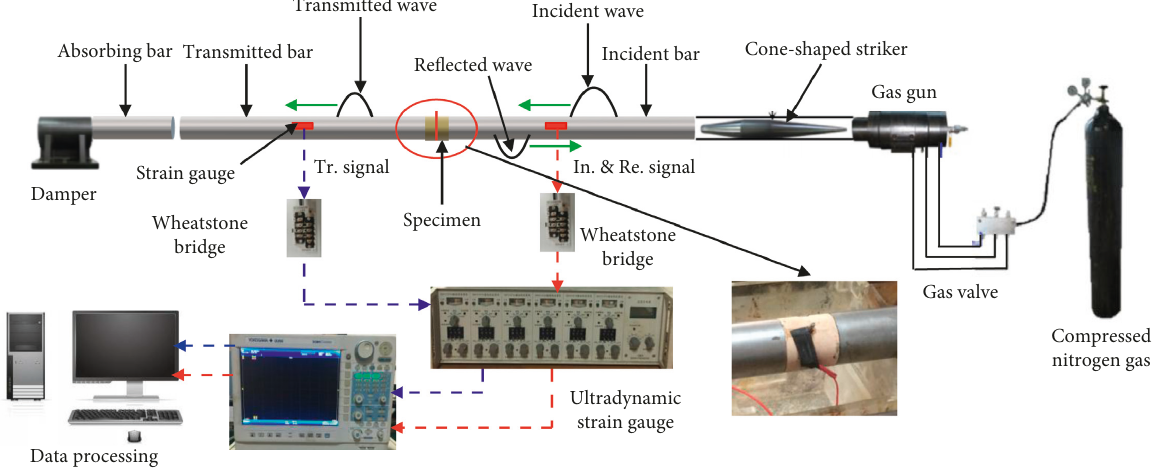
Figure 4: Schematic of the SHPB